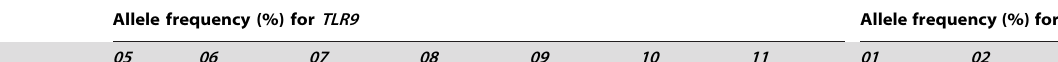
Breed Allele frequency (%) for TLR9 Allele frequency (%) for MyD88